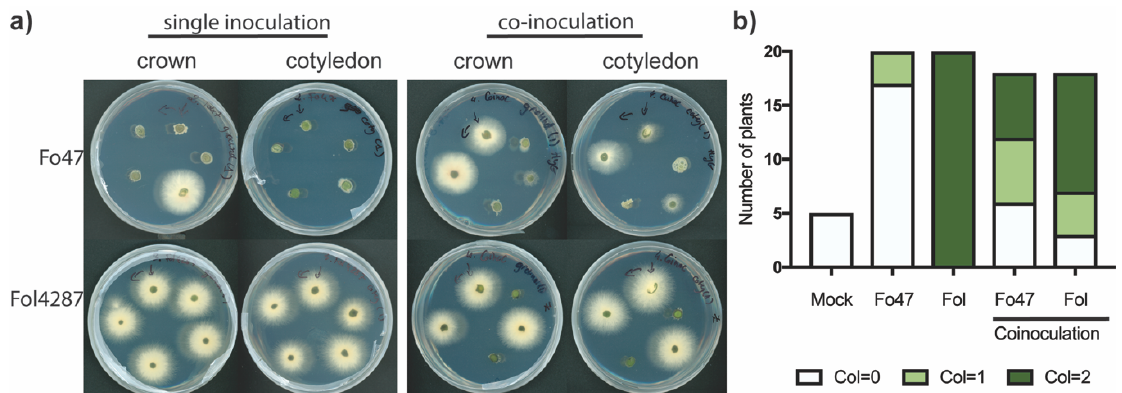
Figure 3. Fo47 colonizes tomato cotyledons upon coinoculation with Fol4287, while Fol4287 colonization is reduced. ( a ) Representative potato dextrose agar (PDA) plates with tomato pieces taken from crown and cotyledon level four days after incubation in the dark at 25 ◦ C; ( b ) plates were scored as following: No Fo outgrowth is represented as white (Col = 0), Fo outgrowth at either crown or cotyledon level is represented in light green (Col = 1) an outgrowth at both crown, and cotyledon level (Col = 2) is represented in dark green. This experiment was performed three times with similar